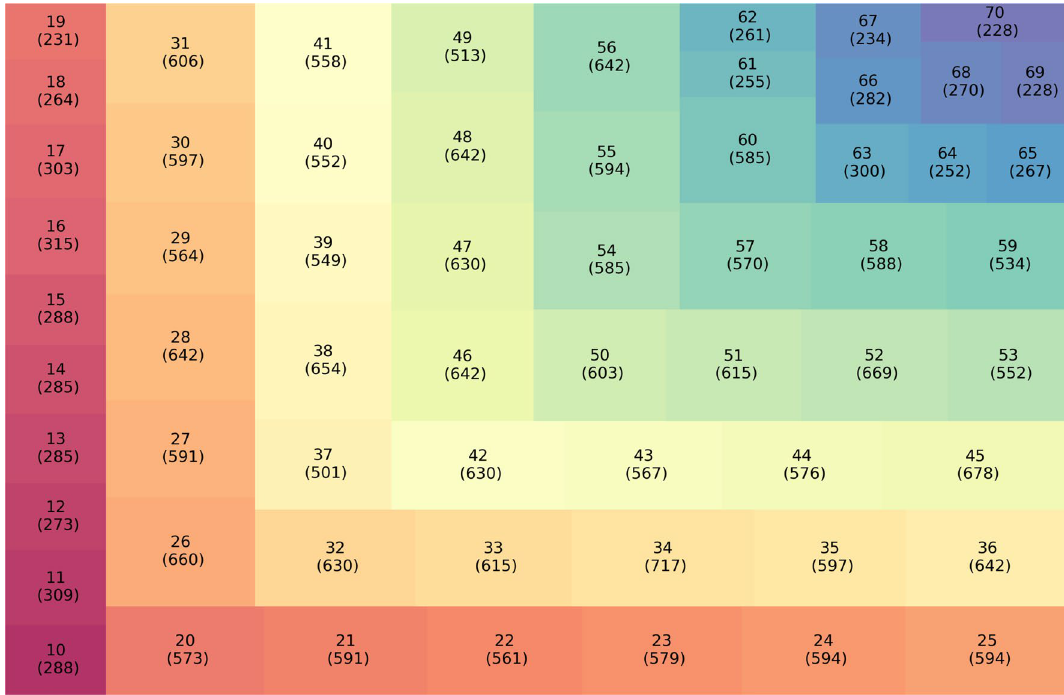
Figure 3. A treemap of gold thickness and the corresponding number of counts of reflective